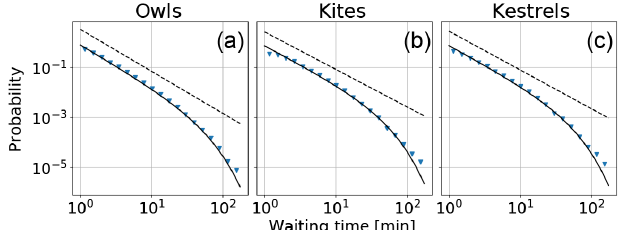
FIG. 5. WT probability densities (symbols) within a radius of 15 m, for 14 owls (a), 6 kites (b), and 10 kestrels (c), all adults. The solid line is a fit to a truncated power law, P ð τ Þ ∼ τ − 1 − α e − τ = τ 0 , with α ¼ 0 . 68 , 0.51, 0.55, and τ 0 ¼ 40 , 35, 36 in panels (a), (b), and (c), respectively. These values of α are the average fit values for the joint distribution of all birds within each species, and the power law truncates at τ 0 ¼ 20 – 80 min for all 70 individual birds. The dashed lines are power laws [Eq. (2)] with the same α